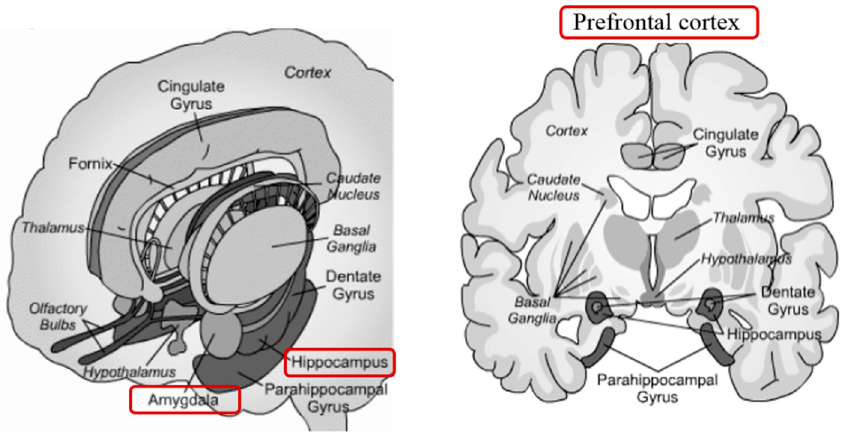
Figure 10. The limbic system is the portion of the brain, which deals with stimulation, arousal, emotions, and memories.